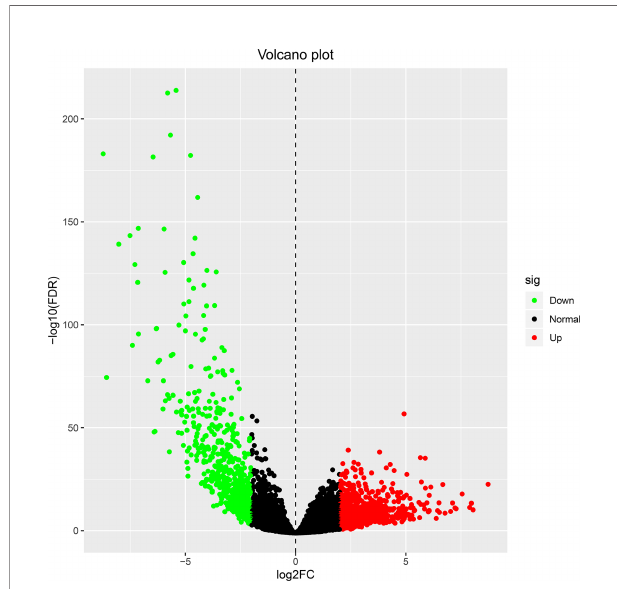
FIGURE 1 | The volcano plot for differentially expressed genes in ccRCC and normal kidney tissue. Genes with adjusted |log FC| > 1.5 and FDR <0.05 values were considered DEGs. Red dots indicate upregulated genes, green dots indicate downregulated genes, and black dots indicate genes without difference. ccRCC, clear cell renal cell carcinoma; FC, fold change; FDR, false discovery rate; DEGs, differentially expressed genes.